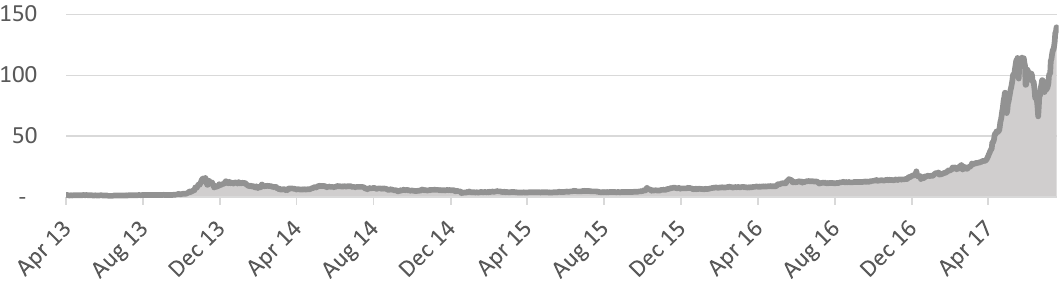
Figure 1. Total market capitalization of cryptocurrencies as of August 14, 2017, in USD